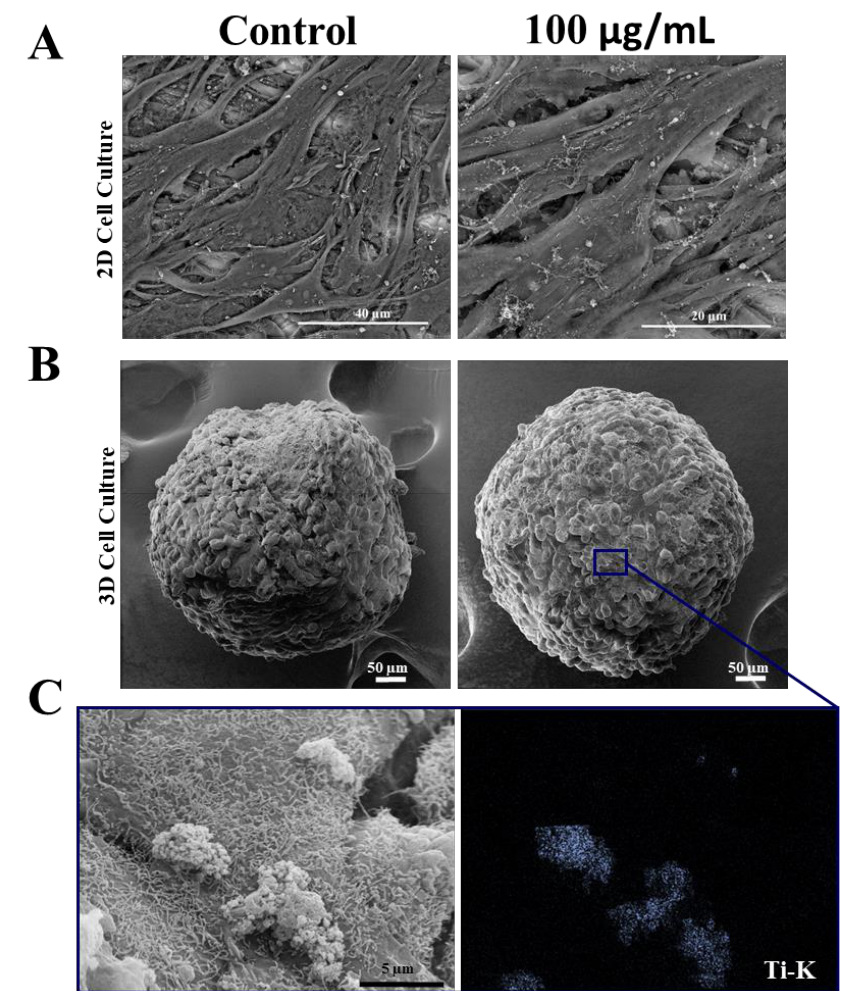
Figure 3. Morphology of human osteoblasts (SAOS-2) cultured in 2D and 3D after exposure to TiO 2 NPs: ( A ) Scanning electron micrographs showing SAOS-2 cultured in 2D and in spheroids ( B ) after treatment with 100 μg/mL of TiO 2 NPs for 3 days. ( C ) STEM/EDS Ti-K map analysis. Ti showed in blue point interacting with cells. Control: cultivation without NPs. The results are representative images of three independent experiments. (scale bar: 40 µm, 20 µm, 50 µm and 5 µm).